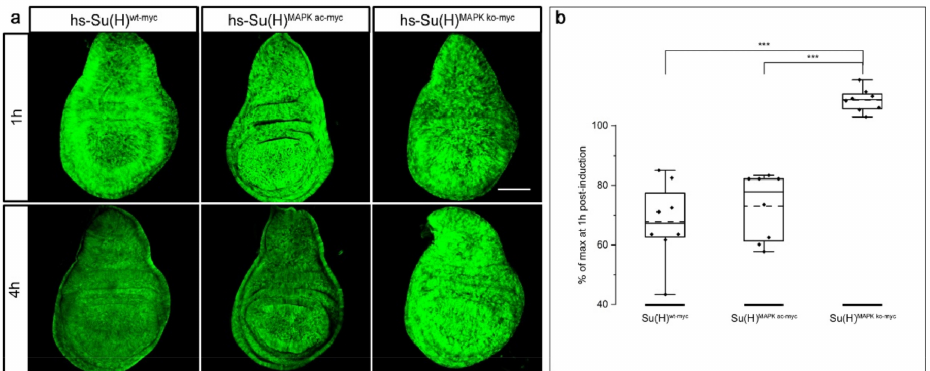
Figure 7. Mutation of the MAPK site precludes Su(H) protein degradation. ( a ) Expression of hs- Su(H) wt-myc , hs-Su(H) MAPKac-myc and hs-Su(H) MAPKko-myc protein, respectively, induced by a 30 min heat pulse, and monitored via the myc tag in wing imaginal discs at 1 h and 4 h after heat shock as indicated. Typical examples are shown. Size bar, 100 µ m in all panels. ( b ) Quantification of eight independent experiments reveals statistically highly significant enrichment of phospho-deficient Su(H) MAPK-ko protein (*** p < 0.001). Full centre lines show medians, dashed lines the average, box limits indicate the 25th and 75th percentiles, whiskers extend the interquartile range by